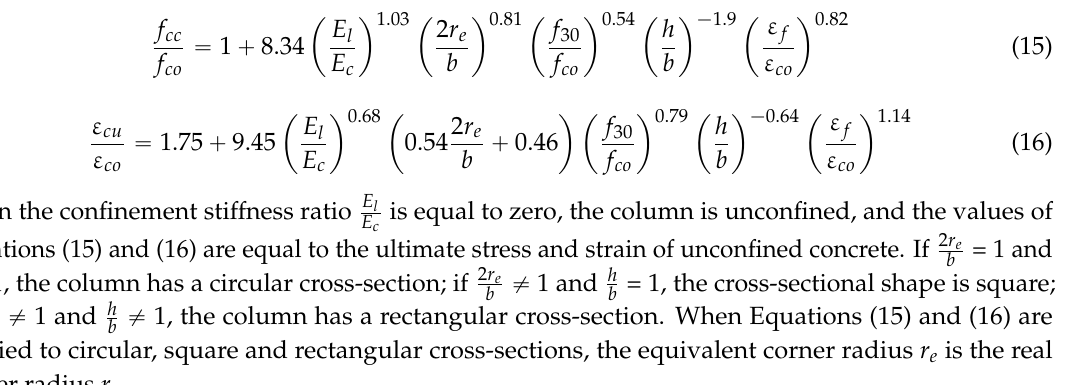
Figure 7. Elliptical cases. ( a ) h « b ; ( b ) h >> b